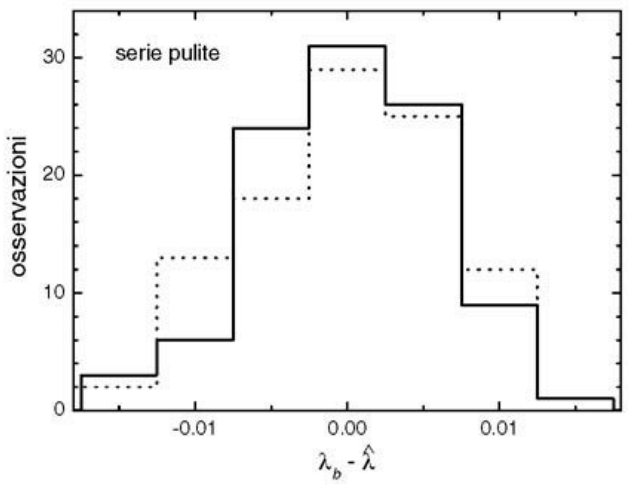
Figura 4 – Distribuzione dell’esponente di Lyapunov massimo dell’attrattore di Rössler ottenuto con 100 serie vere di differenti condizioni iniziali (linea continua) e ricampionando 100 volte un’unica serie (linea a tratto). I parametri usati sono gli stessi riportati in Fig.